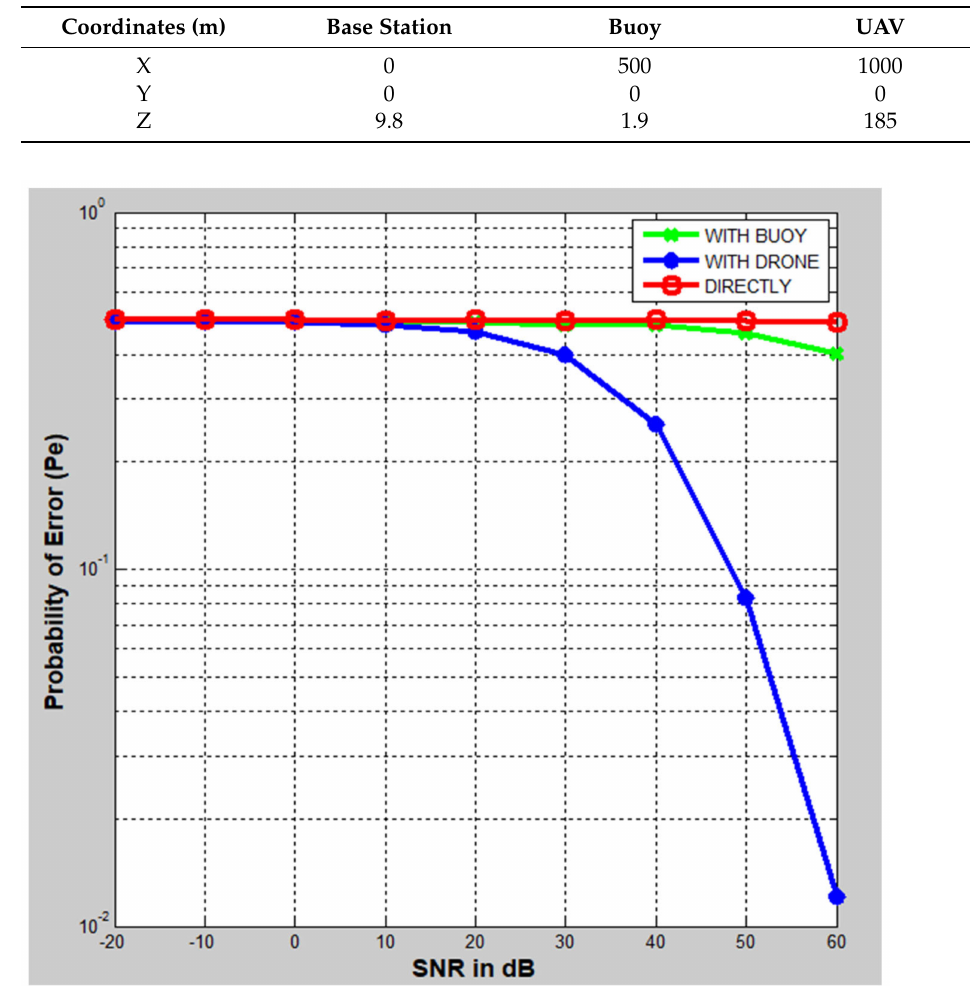
Figure 4. Comparison of signal loss directly, with buoy and with